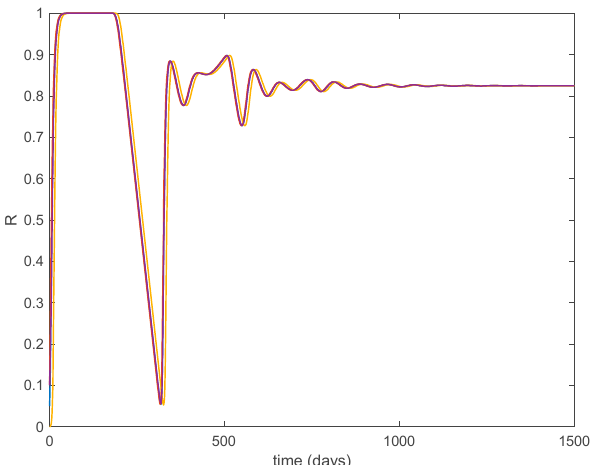
26 of 34 Figure 11. Global asymptotical stability of the endemic equilibrium point for Case 1.6 conditions. Case 1.7. The vaccination gain is